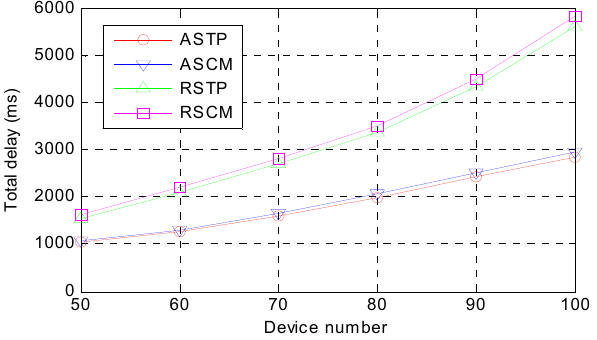
Figure 4. Comparison of the total time delay.